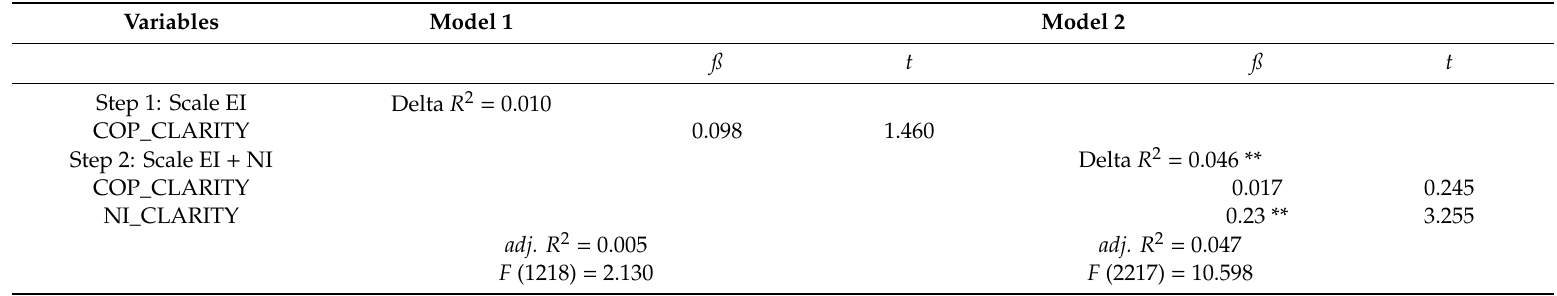
Table A6. Hierarchical regression analyses for the relation between well-being and scales from existing instruments (EI) and the new instrument (NI) assessing task clarity.